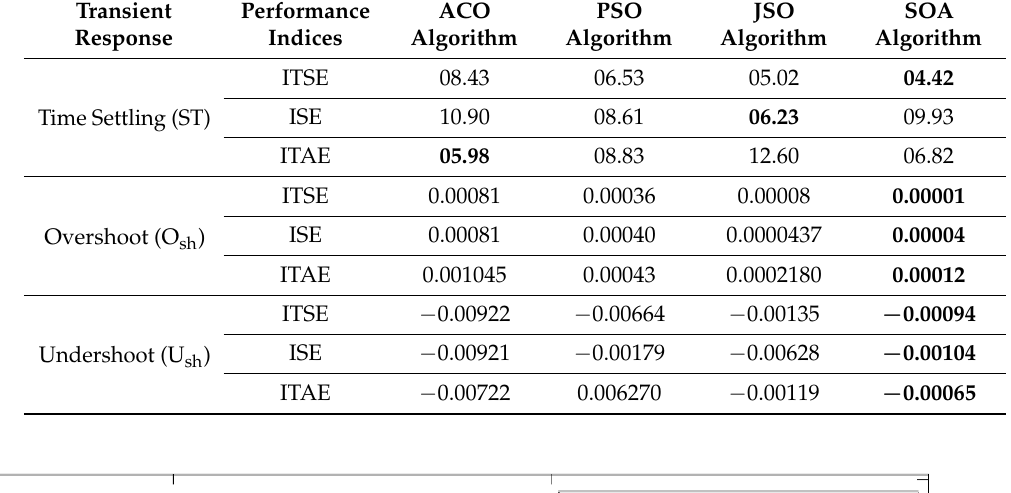
Table 3. Comparison performance of different algorithms using different performance indices.